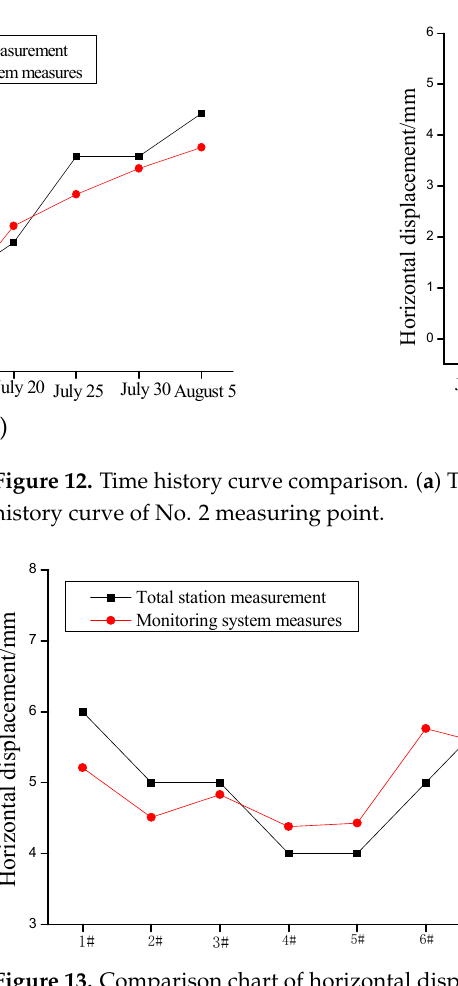
Figure 13. Comparison chart of horizontal displacement of monitoring points.